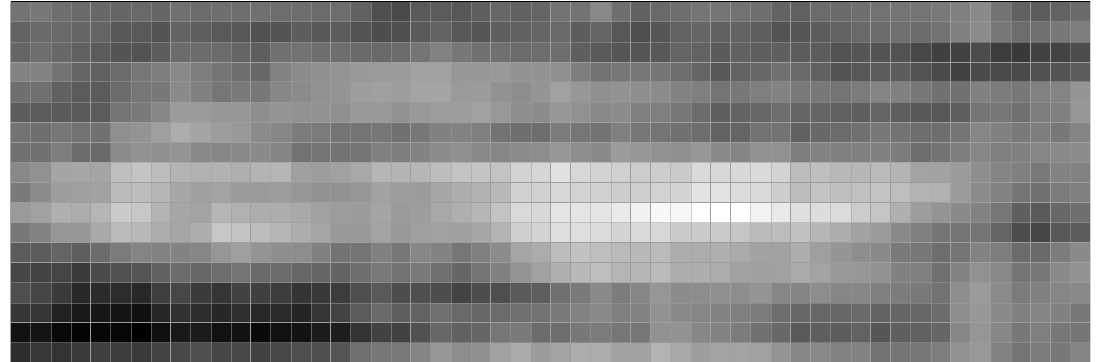
Figure 4: Exemplary realisation of random field modelling cohesion for θ